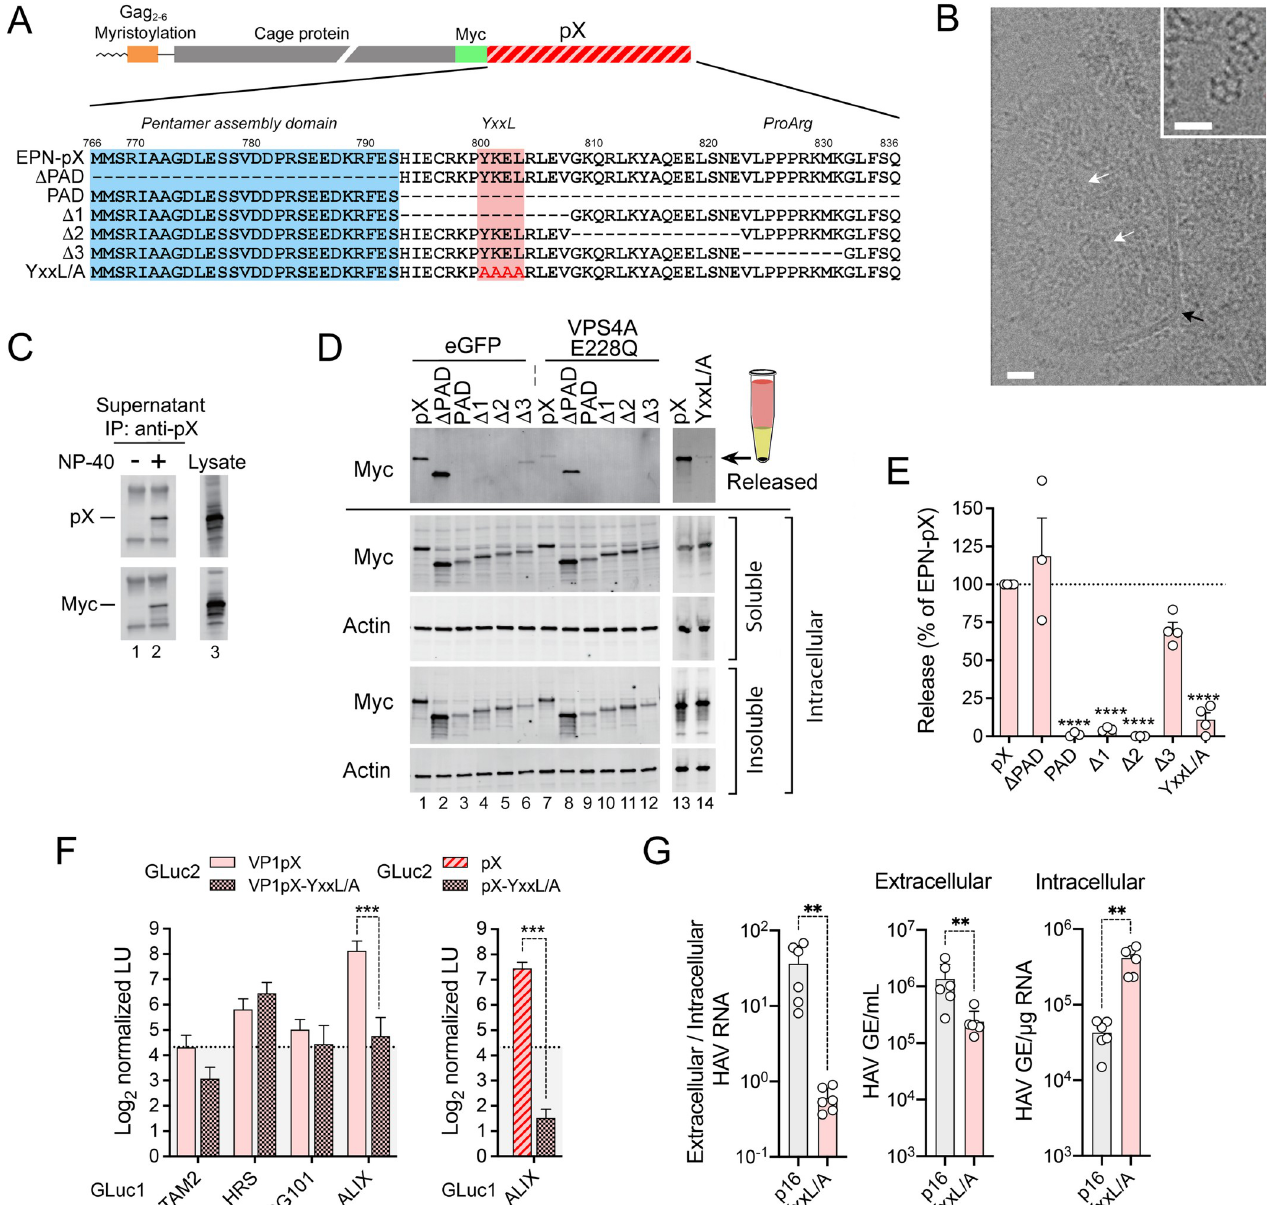
Fig 2. pX mediates ESCRT-dependent extracellular release of assembled EPN-pX nanocages and noncytopathic p16 virus. (A) ( top ) EPN-pX, in which pX is fused to the C-terminus of the nanocage protein with an intervening Myc tag. ( bottom ) pX sequence in EPN-pX and related mutants. The pentamer assembly domain (PAD) [21] and YxxL motif are indicated. Δ 1, Δ 2 and Δ 3 deletions were described previously [23]. (B) Representative electron micrograph showing multiple EPN-pX nanocages ( white arrows ) within a membrane-bound vesicle ( black arrow) in extracellular fluids of transfected 293T cells. Scale bar = 20 nm. The inset shows nanocages in extracellular fluids treated with CHAPS. Scale bar = 30 nm. (C) pX and Myc immunoblots of anti-pX immunoprecipitates of extracellular fluids, with and without NP-40 treatment, versus lysate from EPN-pX transfected cells. (D) Myc immunoblot of released EPN protein recovered following centrifugation through a 20% sucrose cushion, with soluble and insoluble intracellular EPN proteins expressed by cells transfected with EPN-pX and related constructs shown below the solid horizontal line. Cells were co-transfected with vectors expressing eGFP (control, lanes 1–6) or the E228Q VPS4A mutant (lanes 7–12). (E) Quantitation of nanocage protein release normalized to intracellular protein expression. Results are means ± S.E.M. from 3 independent experiments. ���� p < 0.0001 by ANOVA with Sidak’s multiple comparison test. (F) Protein-fragment complementation assay with ( left ) VP1pX and ( right ) pX GLuc2 baits with and without YxxL/A substitutions and GLuc1 prey fused to ESCRT components. Results are means ± S.D. from two independent experiments, each with 3 technical replicates. ��� p < 0.001 by two-way ANOVA with Sidak’s multiple comparison test. (G) Extracellular HAV RNA determined by RT-PCR [genome equivalents (GE) per mL supernatant fluids] and intracellular HAV RNA [GE per μ g total RNA], and calculated extracellular/intracellular RNA ratios, 12 days after transfection of cells with p16 or p16-YxxL/A RNA; GE = genome equivalents. Data are from n = 6 cultures from two transfections, and are representative of multiple independent experiments. �� p < 0.01 calculated by Mann-Whitney test. https://doi.org/10.1371/journal.ppat.1010543.g002 PLOS Pathogens| https://doi.org/10.1371/journal.ppat.1010543 August 15,